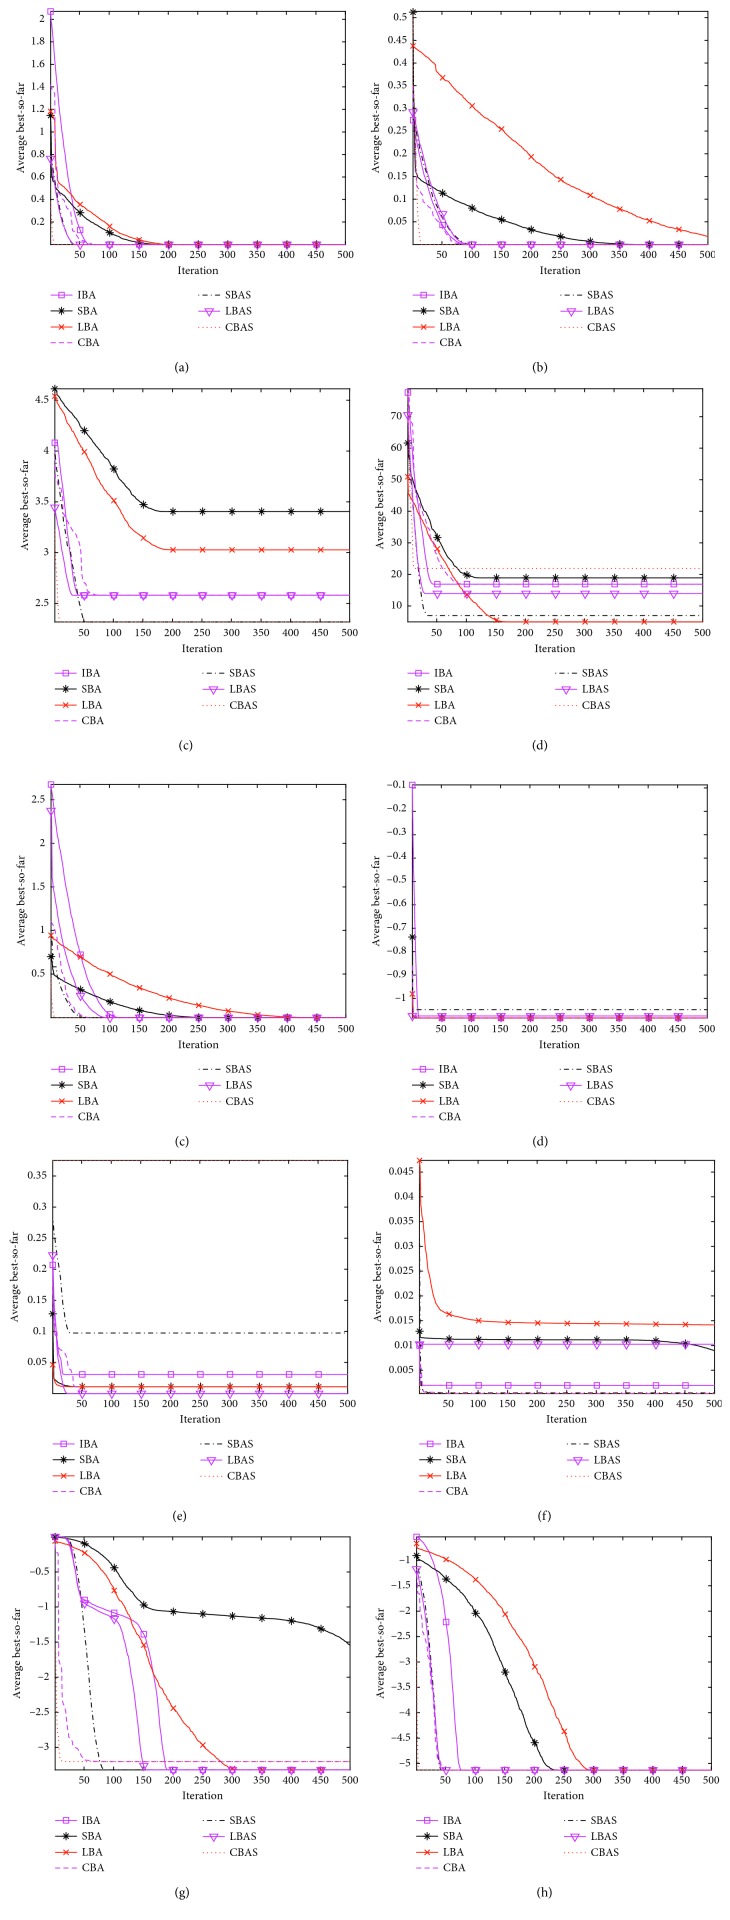
Convergence curves for typical function optimization problems under seven algorithms. (a) F1. (b) F2. (c) F3. (d) F5. (e) F6. (f) F7. (g) F8. (h) F9. (i) F10. (j) F11.